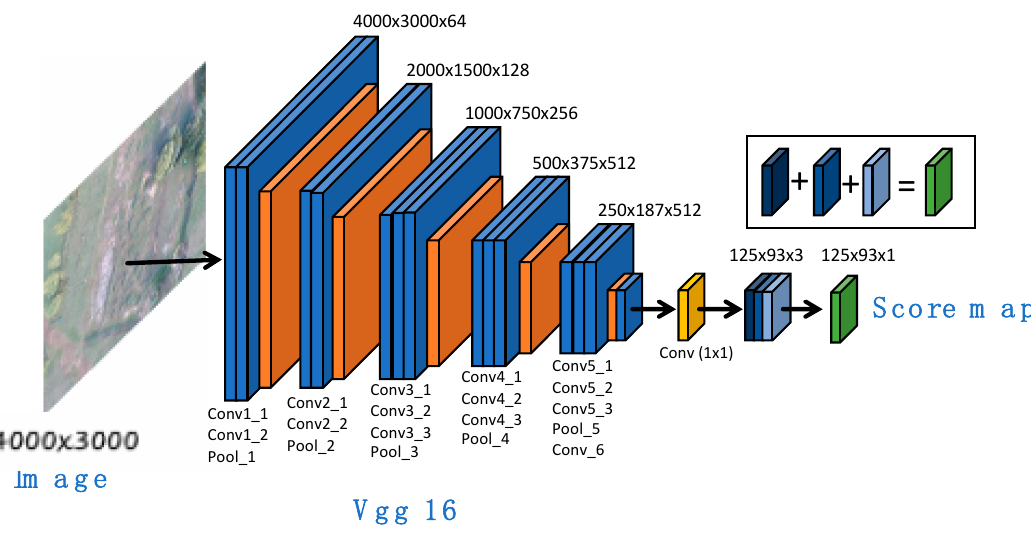
Figure 5. A convolution neural network (CNN) network used to extract features and predict the score map.